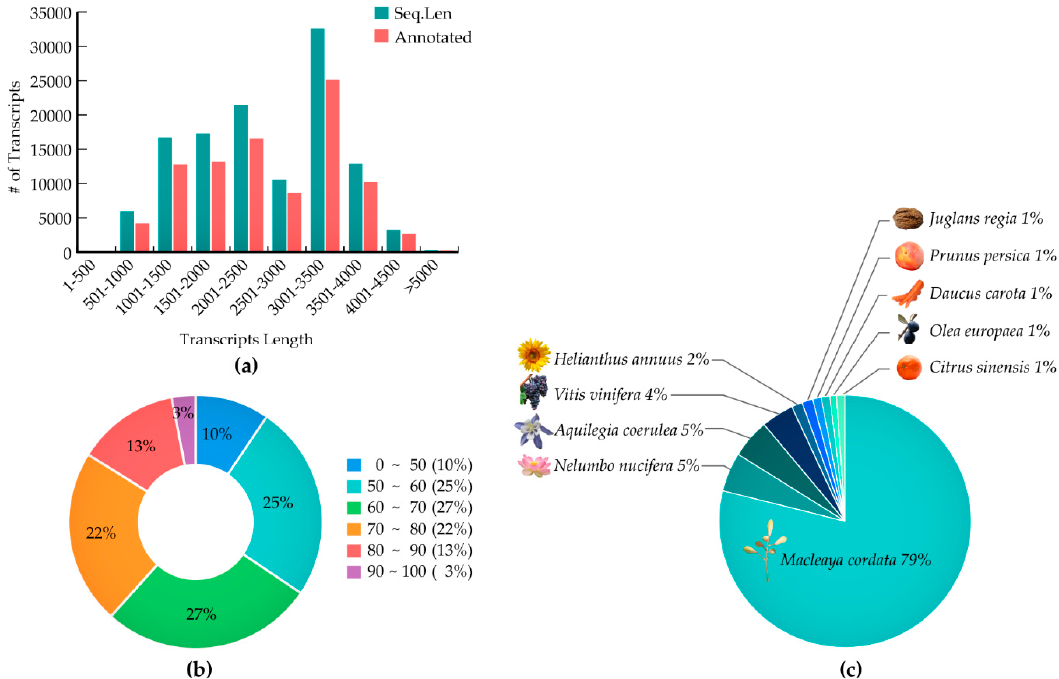
Figure 1. Illustration of the transcriptome assembly and functional annotation summary; ( a ) length distribution of assembled transcripts with and without annotations; ( b ) distribution of